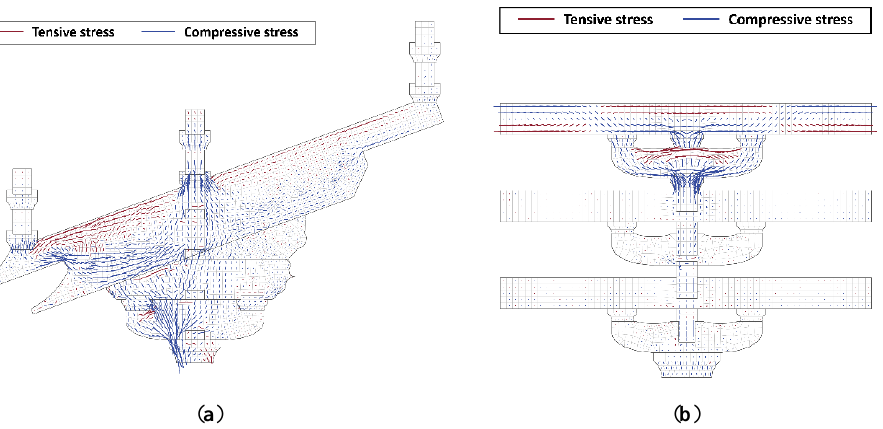
Figure 9. Stress vector diagram of the Tou-xin-zao Dou-gong in the roof load case: ( a ) longitudinal section; ( b ) transverse section.